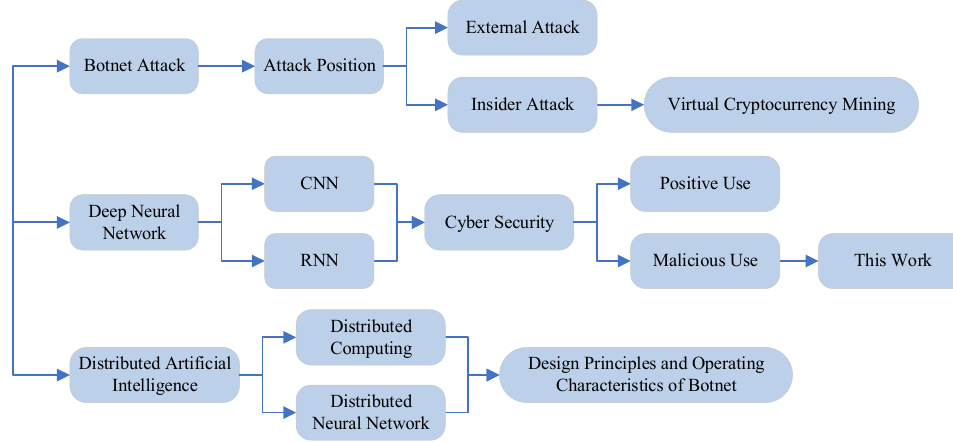
Figure 1. Background and related work.